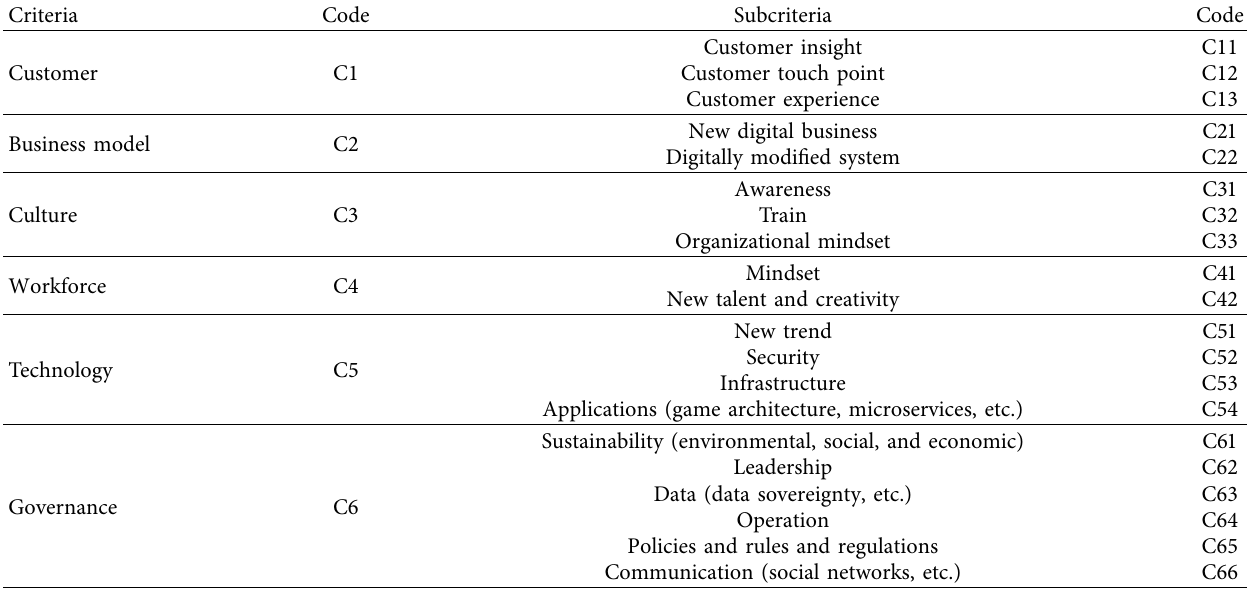
Table 5: The main criteria and subcriteria in the study.